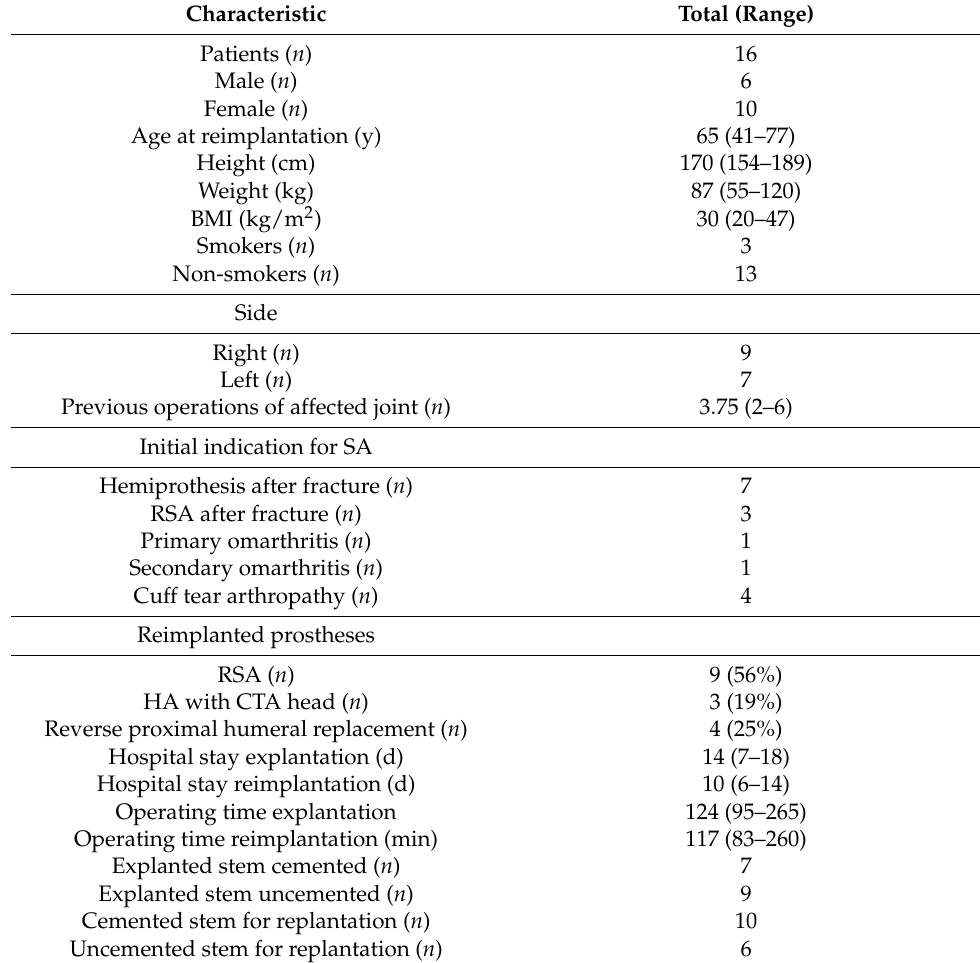
Table 1. Baseline table of included patients. BMI: body mass index, SA: shoulder arthroplasty, RSA: reverse shoulder arthroplasty, HA: hemiarthroplasty, CTA: cuff tear